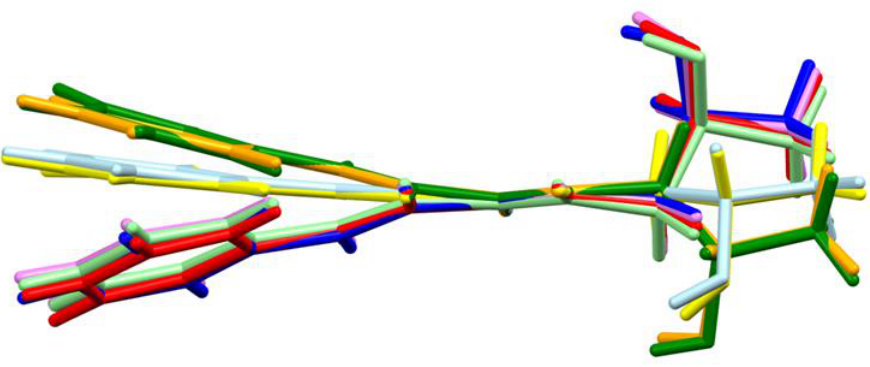
Figure 5. The overlap of amide groups of eight molecules: A yellow, B orange, C red, D light green, E green, F light blue, G blue and H violet.